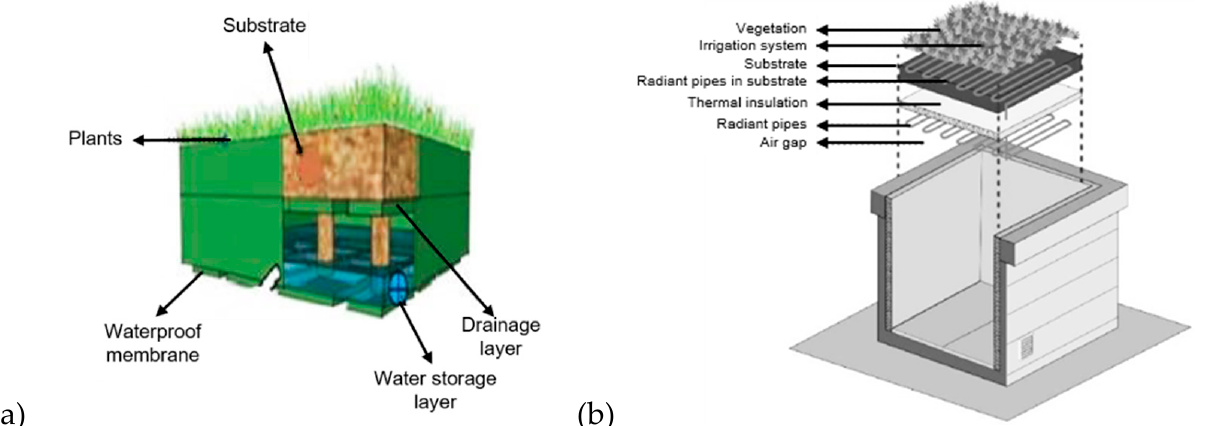
Figure 4. Schematic diagram of ( a ) a typical green–blue roof and ( b ) a pilot-scale green roof integrated with a radiant cooling system.